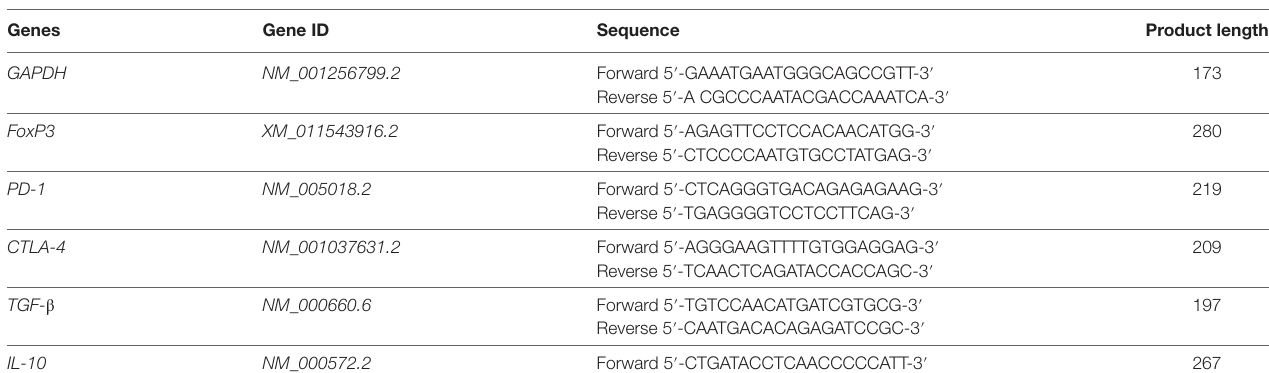
TaBle 2 | Real-time PCR primers used in this